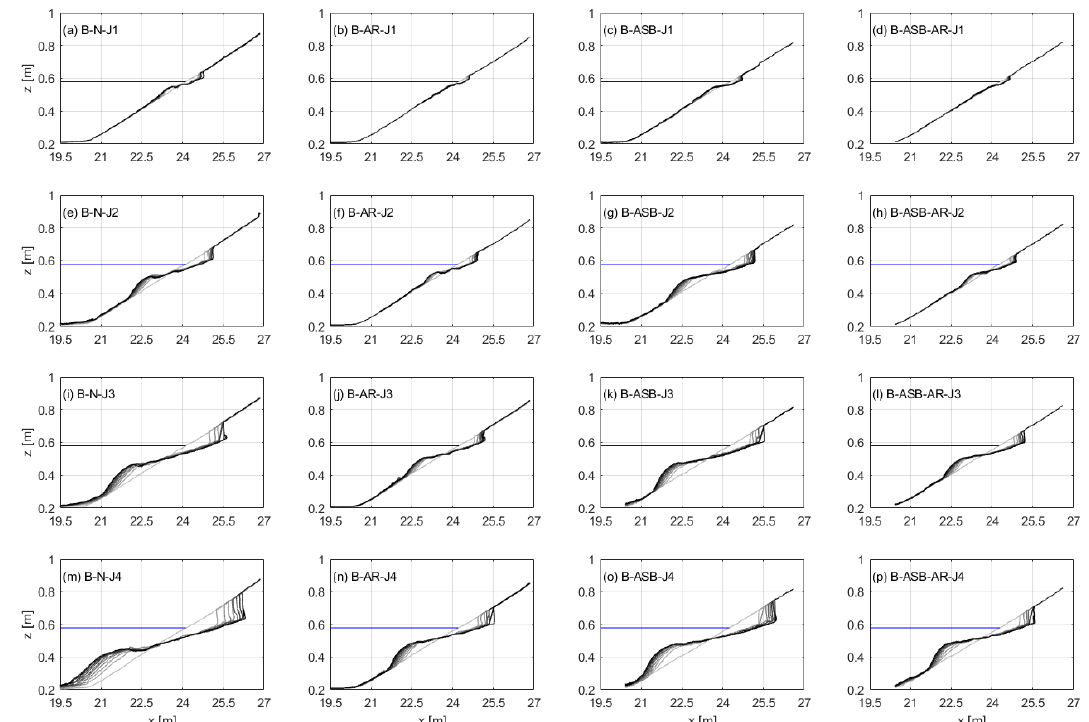
Figure 5. The beach evolution process (profiles in each test were captured every 10 min for a total of 90 min, as shown with colors changing from light to dark as time progresses).